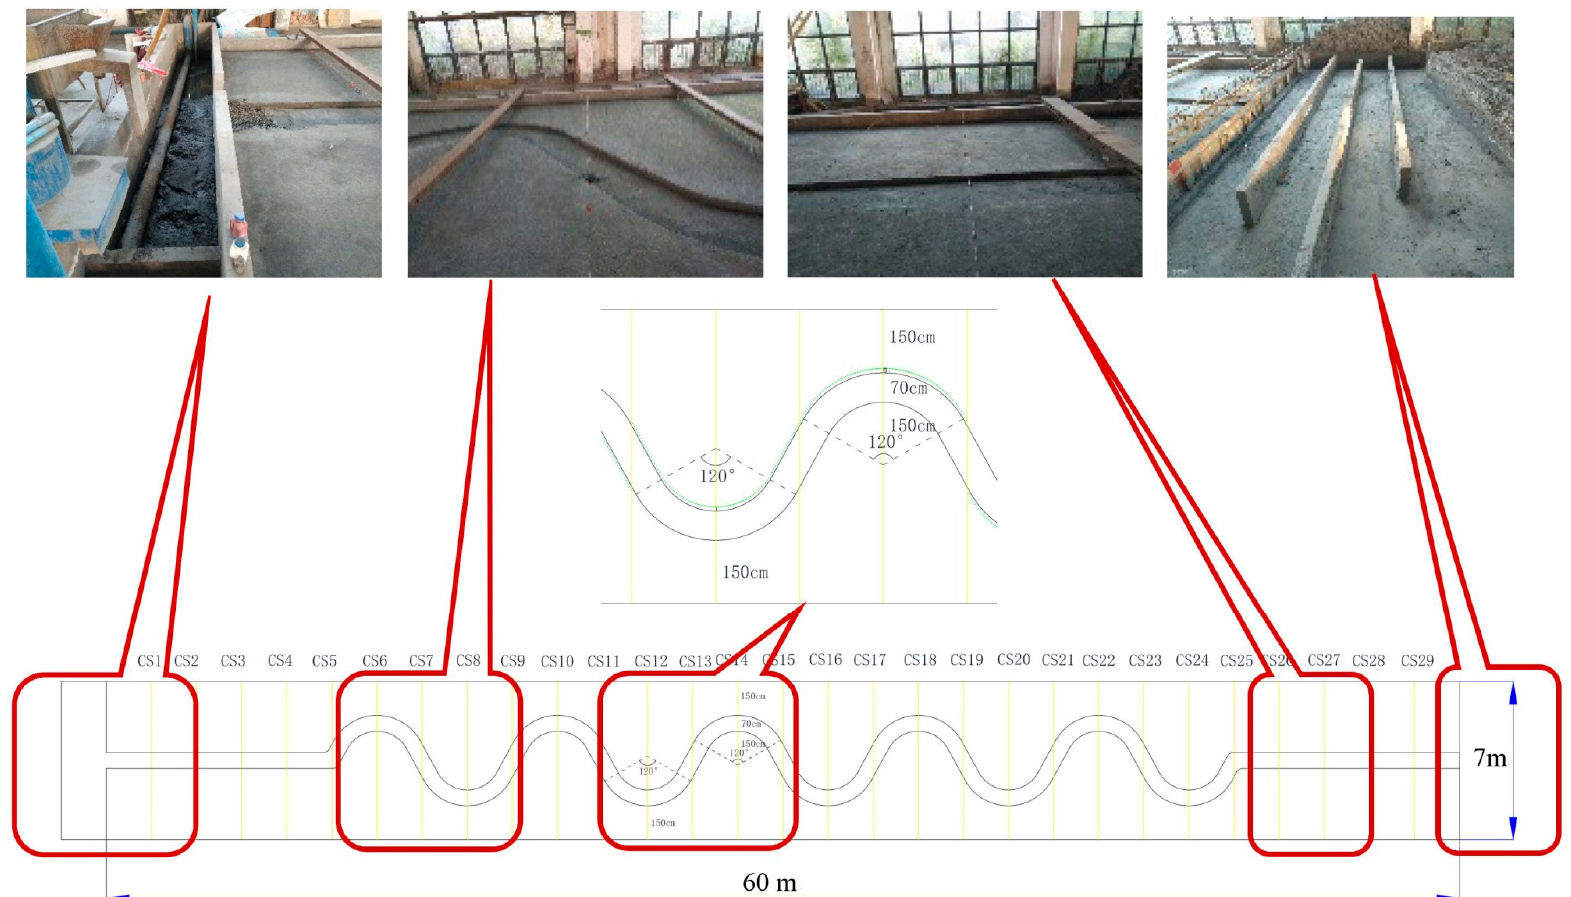
Figure 1. Layout of the generalized flume model.